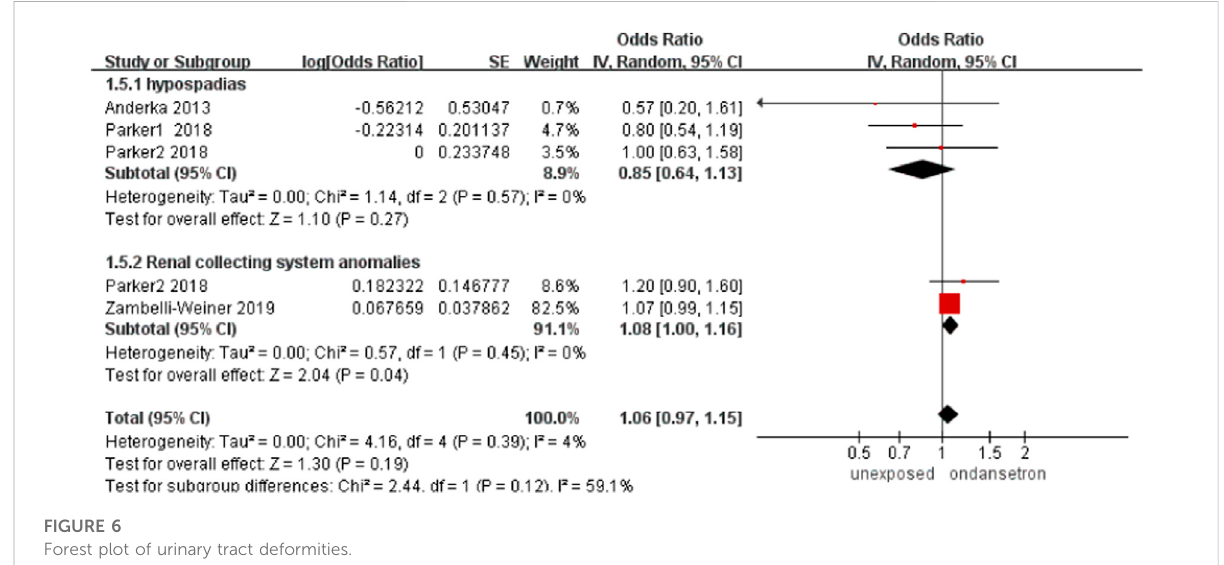
FIGURE 6 Forest plot of urinary tract